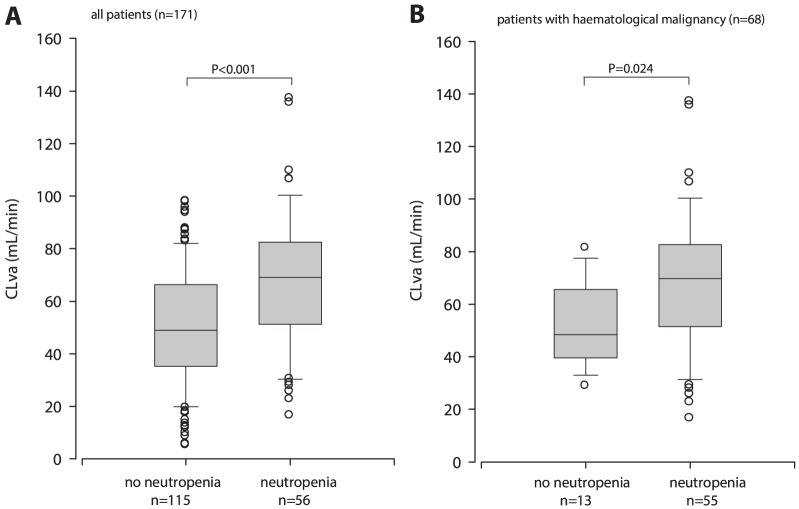
Boxplot for vancomycin clearance (CLva) in patients with and without neutropenia in all patients (A) and in patients with haematological malignancy (B).Lower and higher boundary of the box indicates 25th and 75th percentile, respectively, the line within the box marks the median, the whiskers above and below the box indicate the 90th and 10th percentiles and the open circles indicate outside the 90th and 10th percentiles.